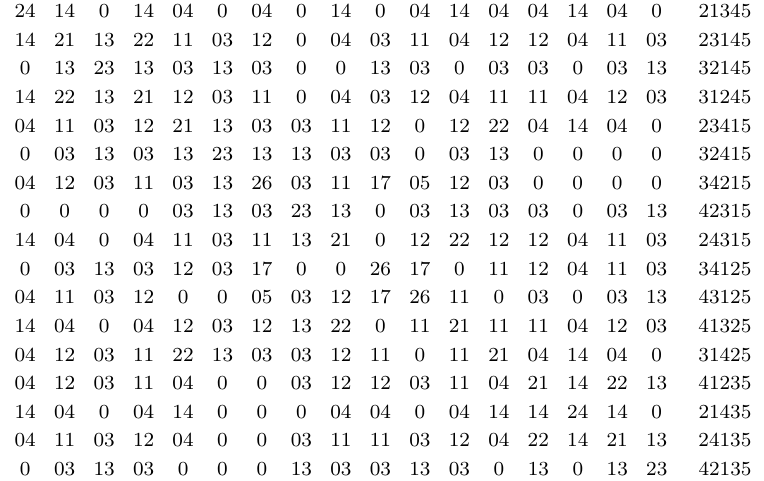
F ( j ) gg , and a single 0 means that c